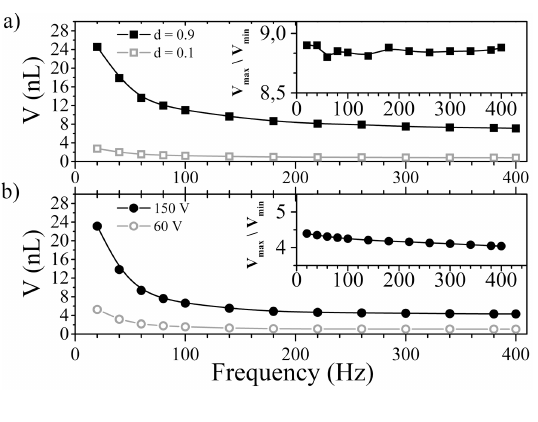
Figure 3. Formation of drops of different volumes in a single cycle obtained in ( a ) digital control and ( b ) analogue control. Insets show the ratio of maximum to minimum volume of drops as a function of the frequency of valve operation. The droplets were formed in 100 × 100 μ m 2 square cross-section channel. During the experiments the values of pressure p oil (1500 mbar) and p water (2000 mbar) were